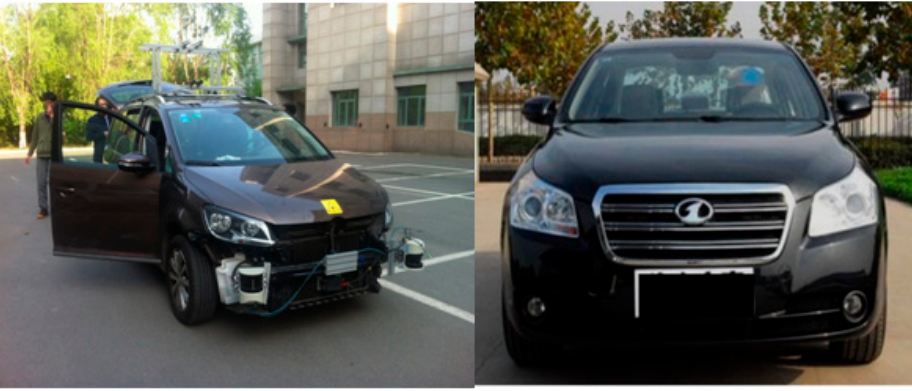
Figure 6. The test car at the left side and the forward car at the right side.